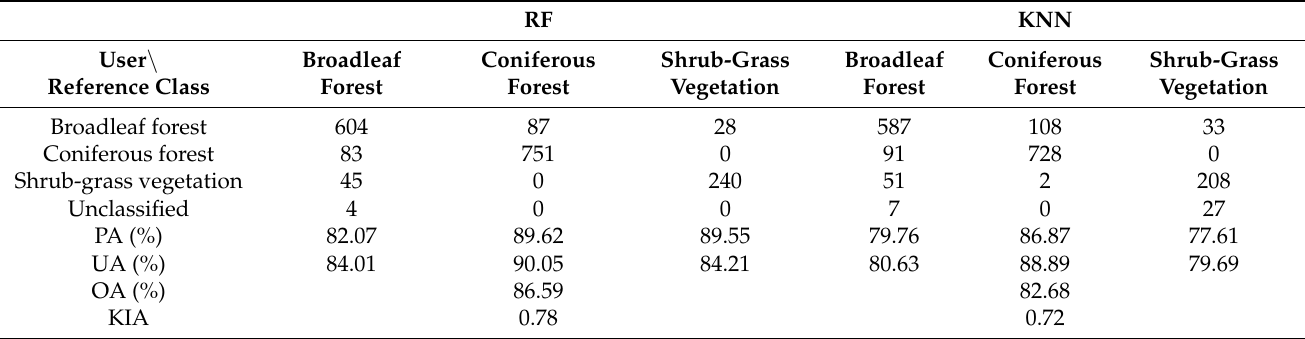
Table 3. Confusion matrix.